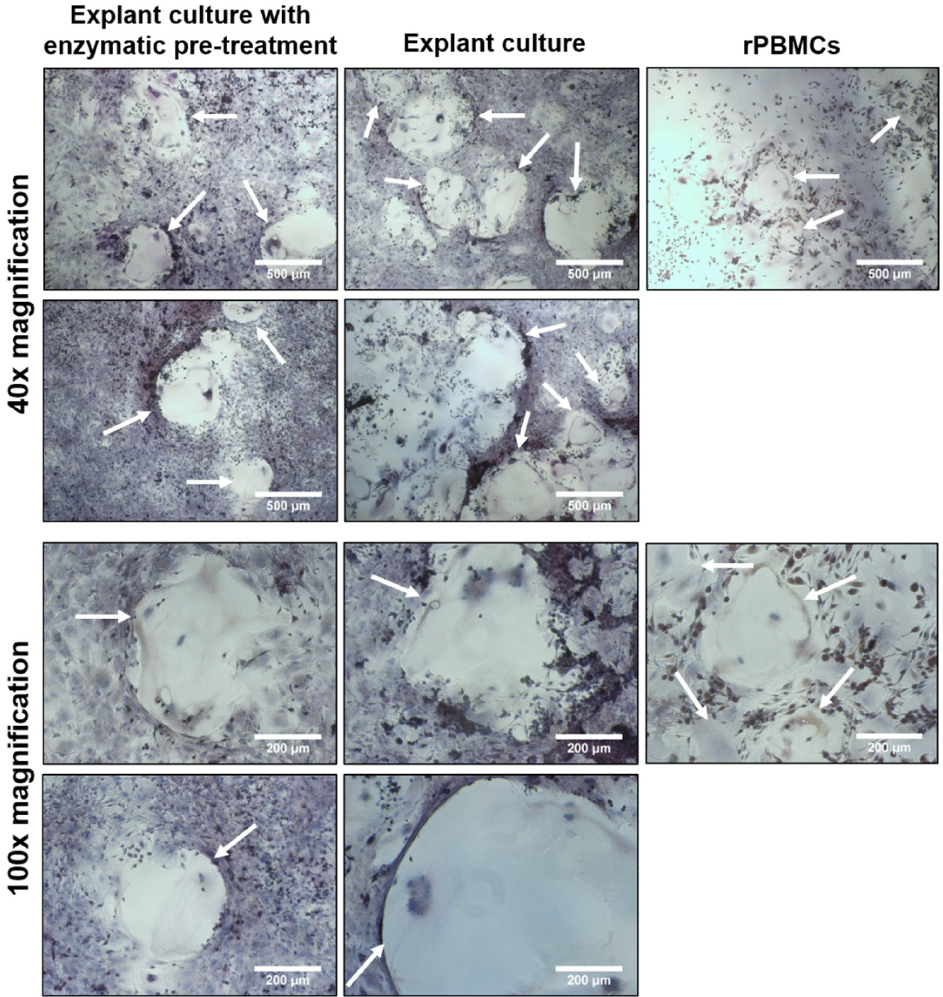
Figure 7. TRAP staining in co-cultures of rPBMCs and rOBs isolated either by explant culture with enzymatic pre-treatment or explant culture on day 14, cultured with exogenous GFs (M-CSF, RANKL). Images from two individuals for each isolation method are shown in a magnification of 40× and 100× (scale bar 500 μ m and 200 μ m, respectively). rPBMCs served as a control of osteoclastogenesis and were cultured only with exogenous GFs. TRAPs were stained by a TRAP kit and nuclei were stained by hematoxylin. White arrows show formed rOCs.